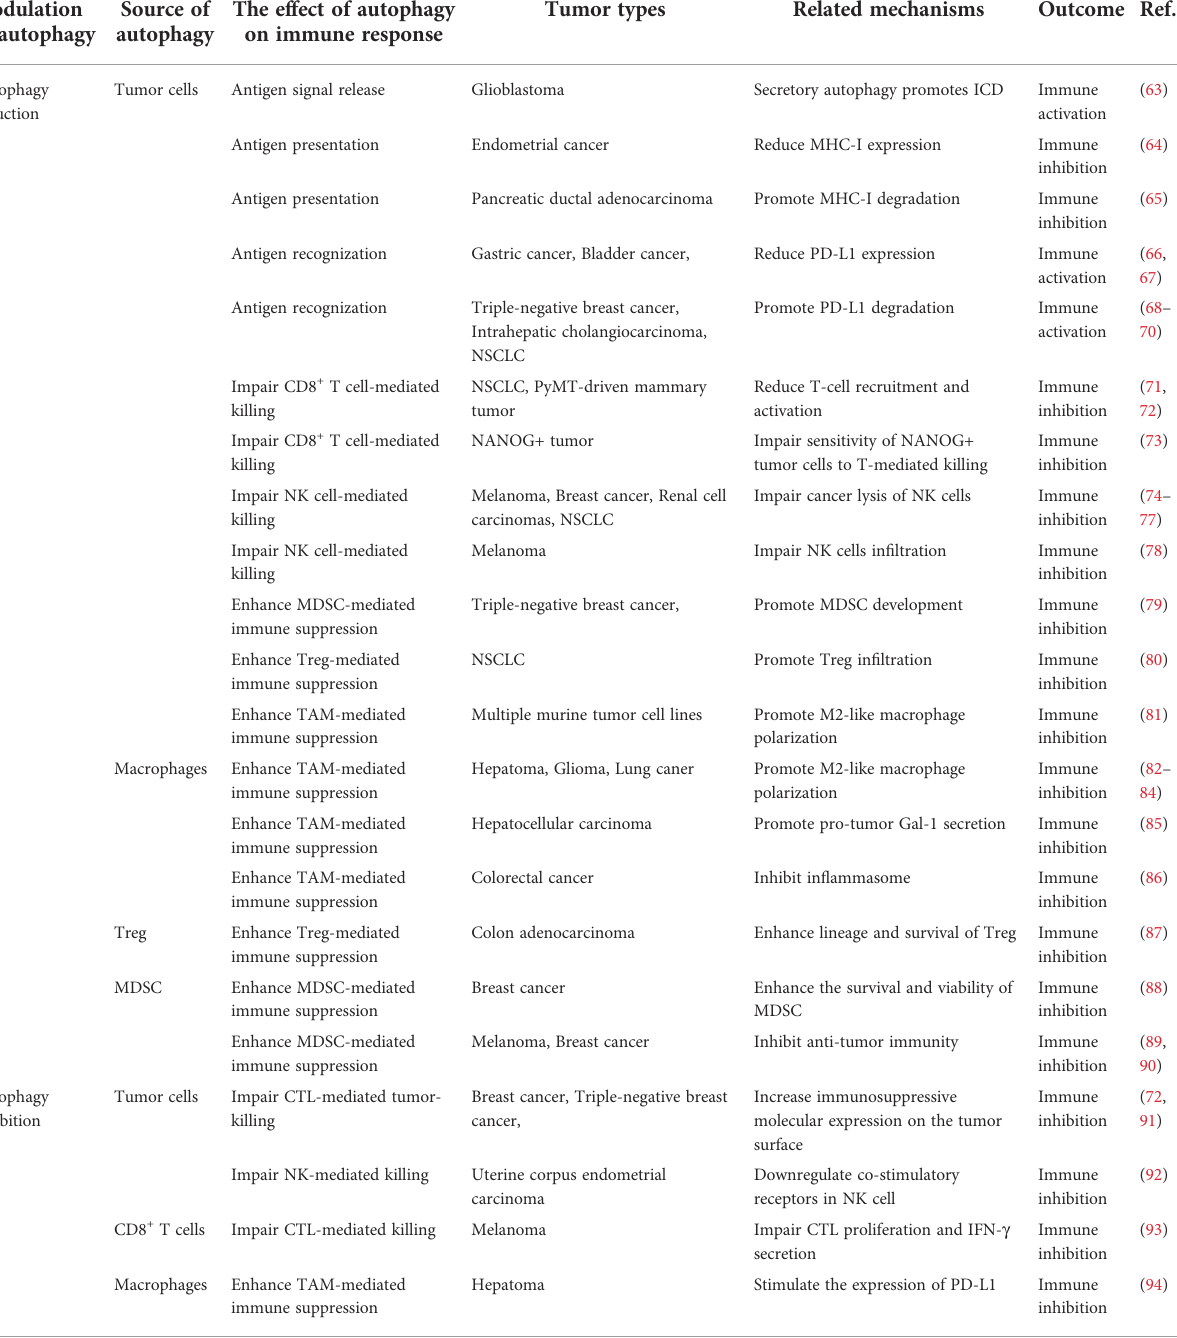
TABLE 1 The role of autophagy in the transformation of hot TME to cold TME. Modulation of